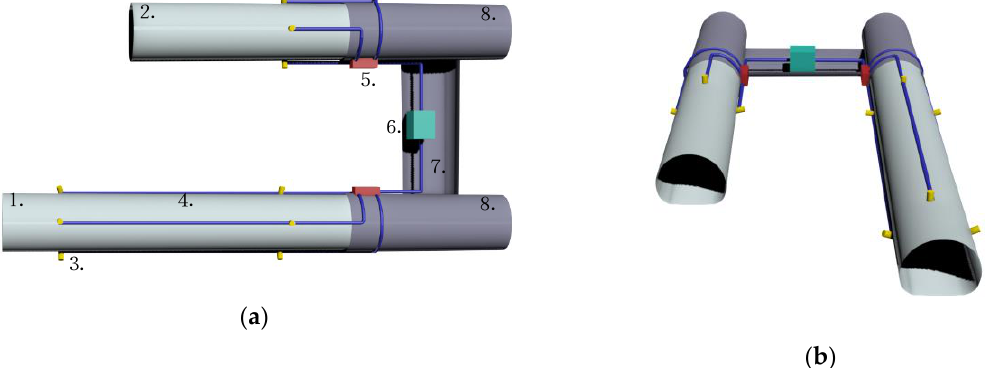
Figure 10. Figures ( a ) and ( b ) are the plan and vertical view of arrangement of microseismic monitoring for the twin-tube expressway tunnel: (1) forward tunnel; (2) backward tunnel; (3) sensor array; (4) cable; (5) data acquisition station; (6) data processing station; (7) cross hole; (8) secondary lining.